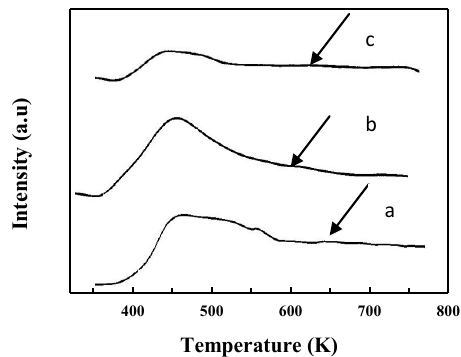
Figure 5. NH 3 -TPD profiles of ( a ) 7.1 wt% Cr 2 O 3 -6.3 wt%NiO/SiO 2 -400; ( b ) 7.1 wt% Cr 2 O 3 -6.3 wt% NiO/SiO 2 -500; and ( c ) 7.1 wt% Cr 2 O 3 -6.3 wt% NiO/SiO 2 -600.